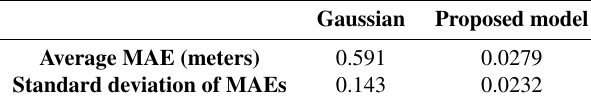
Table 1. Comparison of the average MAE (Mean Absolute Error) on the reconstruction of occluded areas.